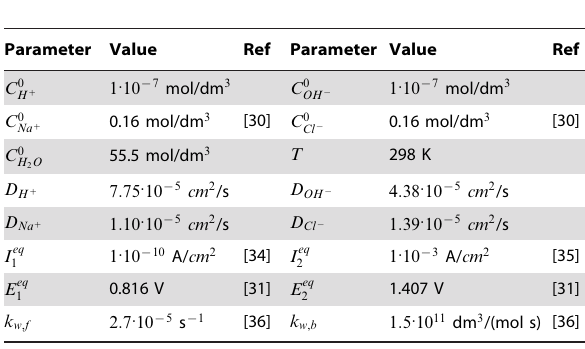
Table 1. Input parameters of the mathematical model.